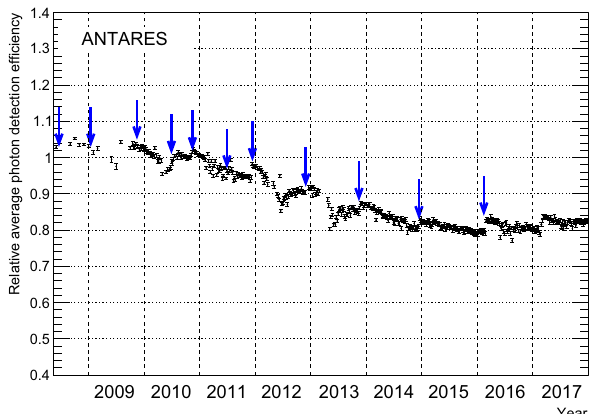
Fig. 4 Relative OM efficiency averaged over the whole detector as a function of time. The blue arrows indicate the periods in which high voltage tuning of the PMTs has been performed, while error bars indi- cate the statistical error σ mean on the mean efficiency